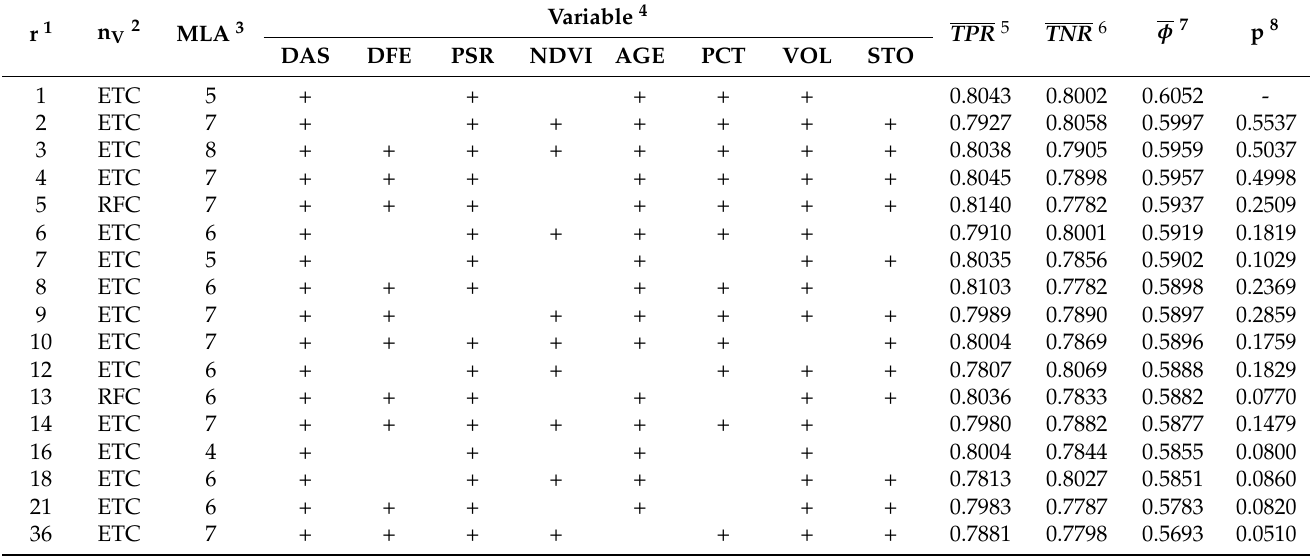
Table A1. Forest damage models not significantly different from the best ETC-based